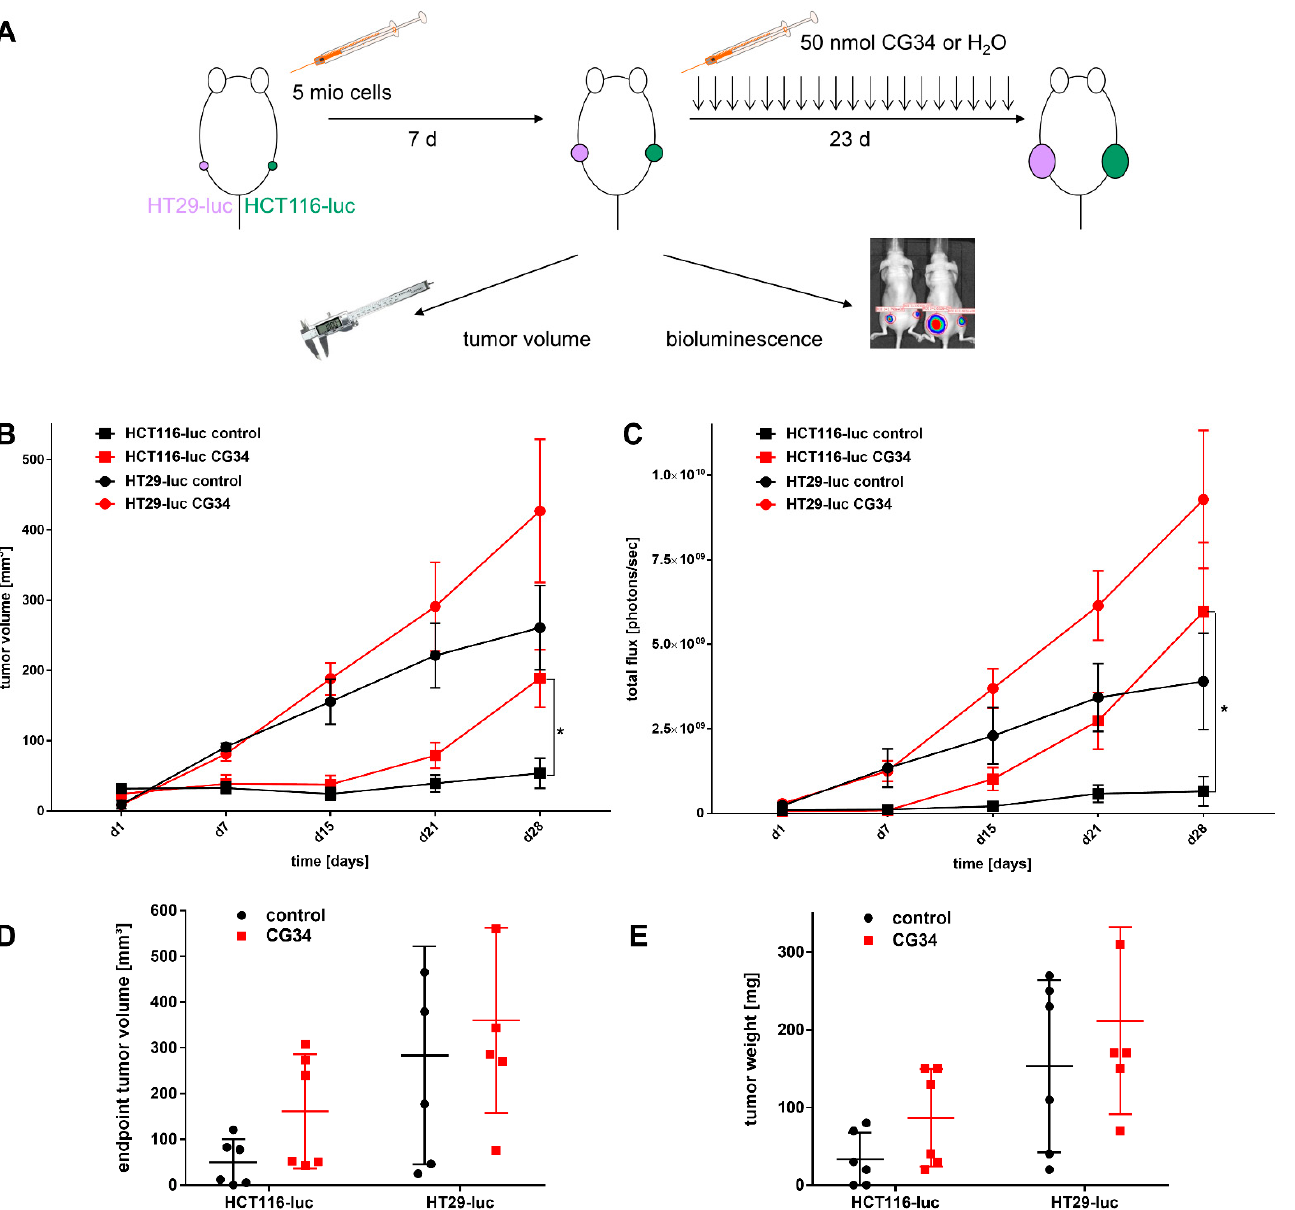
Figure 5. Influence of the chemerin peptide analog CG34 on the growth of two human CRC xenograft mouse models. ( A ) Schematic representation of the tumor inoculation and treatment process. Five million of the luciferase-expressing HCT116-luc and HT29-luc cells were used to inoculate female NMRI nu/nu mice. On day 8 after inoculation, daily treatment with i.p. injections of CG34 or water was started in an investigator-blinded fashion; treatment was continued until day 28. Tumor volume and bioluminescence were recorded weekly. ( B ) Tumor volume measurements performed with a caliper; ( C ) Bioluminescence measurements performed with a high-sensitivity CCD imager; ( D ) Volume measurements performed with a caliper at the end of the experiment after mice had been sacrificed; ( E ) Tumor weight measurements performed at the end of the experiment using explanted tumors. Volume and bioluminescence data ( B , C ) represent mean ± S.E.M. of n = 6 tumors per group. Statistical verification was performed using an unpaired t -test or a Mann-Whitney test; * p < 0.05. Endpoint tumor volume and tumor weight data ( D , E ) represent mean ± SD of n = 6 tumors per